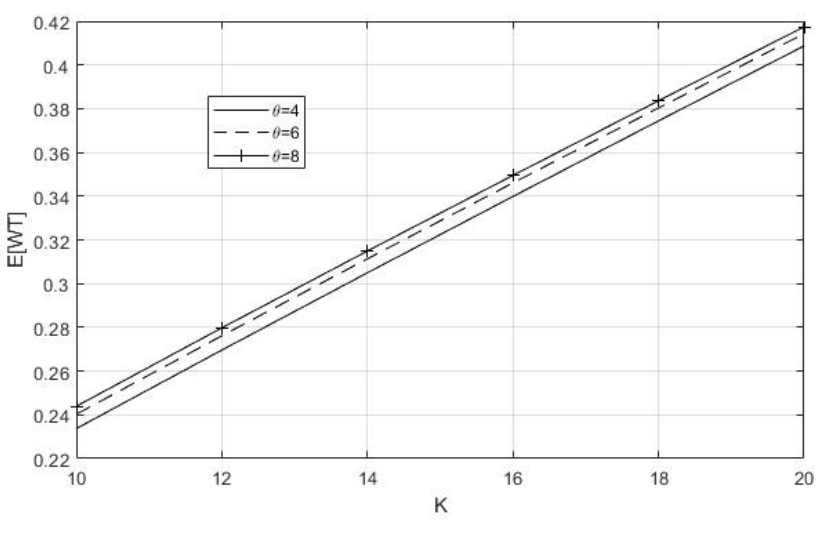
Figure 6: Impact of Impact of E [ W T ] on K vs θ